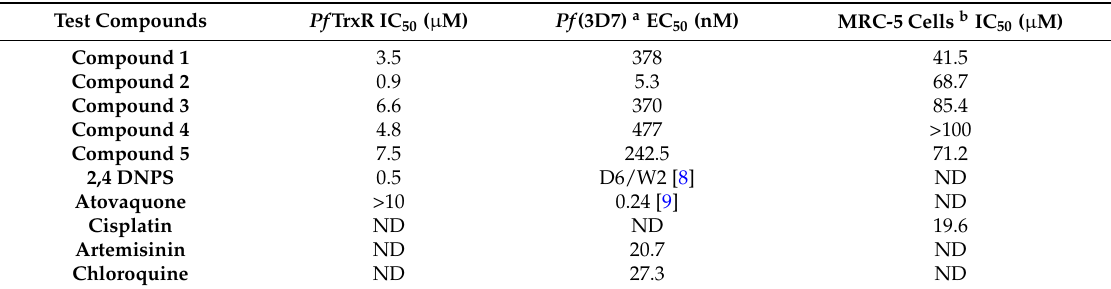
Table 2. Pf TrxR inhibitory, antimalarial and cytotoxic activities of the most active Malaria Box compounds.